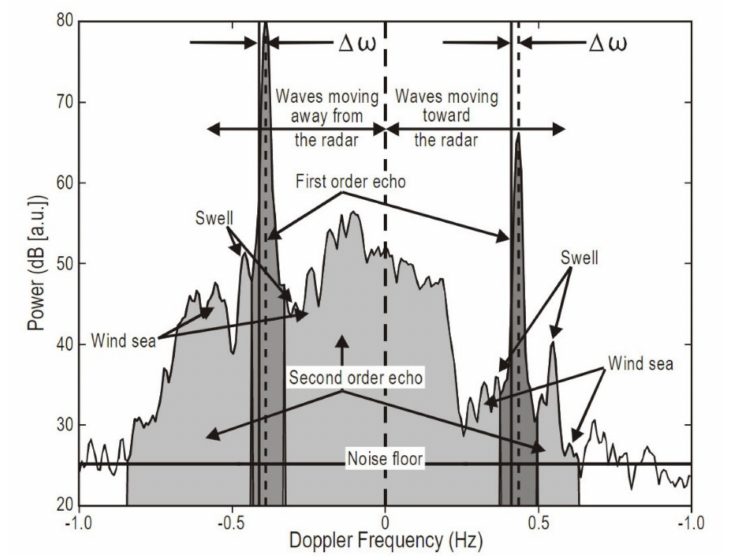
Figure 5. Main characteristics of a typical HF radar spectrum